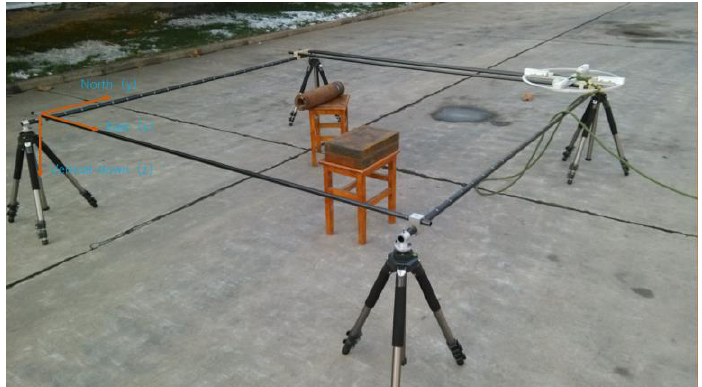
Figure 13. Experimental scene.